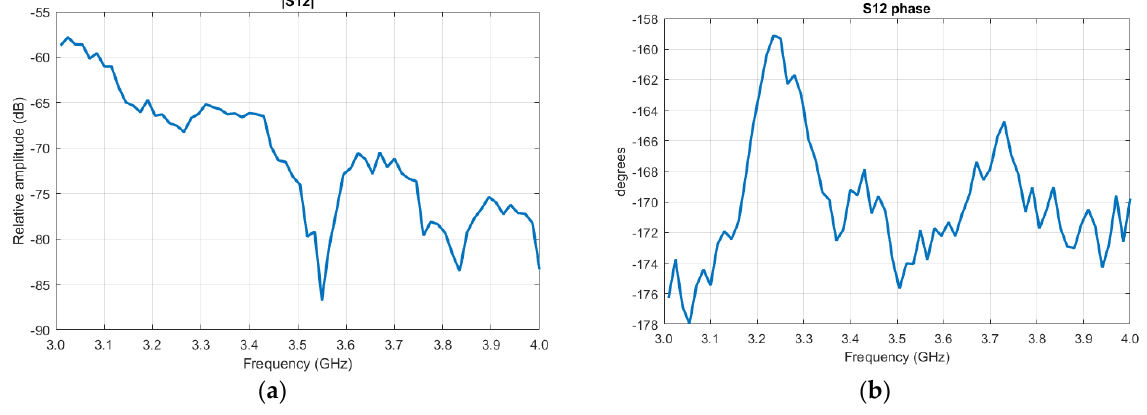
Figure 6. Results of a S 21 measurement as a function of frequency: ( a ) amplitude; ( b ) phase.